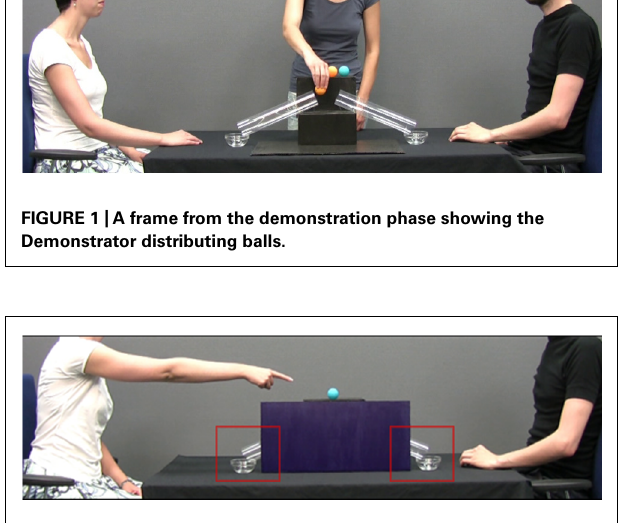
FIGURE 2 |A frame from the test trial in the point group, showing the Gesturer pointing to the ball. The two red squares delineate the areas of